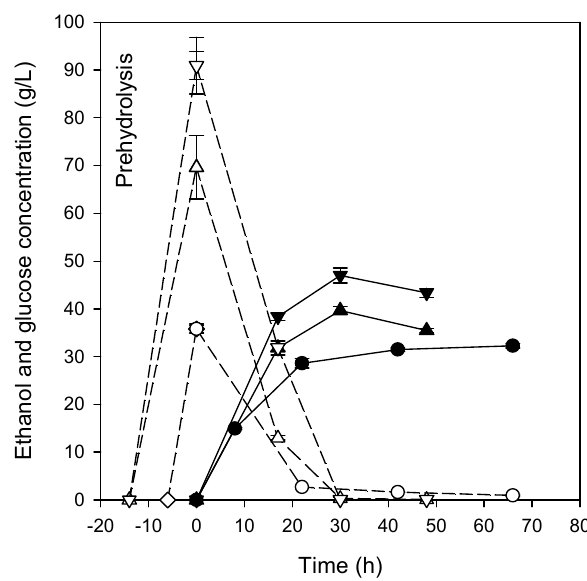
Figure 2. Bioethanol production from organosolv-hydrothermally treated CS at 15% and 20% ( w / v ) substrate concentration applying different pre-hydrolysis times. Symbols: ( ) ethanol and ( ) glucose 6 h pre-hydrolysis at 15% ( w / v ) substrate concentration; ( ) ethanol and ( ) glucose 14 h pre-hydrolysis at 15% ( w / v ) substrate concentration; ( ) ethanol and ( ) glucose 14 h pre-hydrolysis at 20% ( w / v ) substrate concentration.